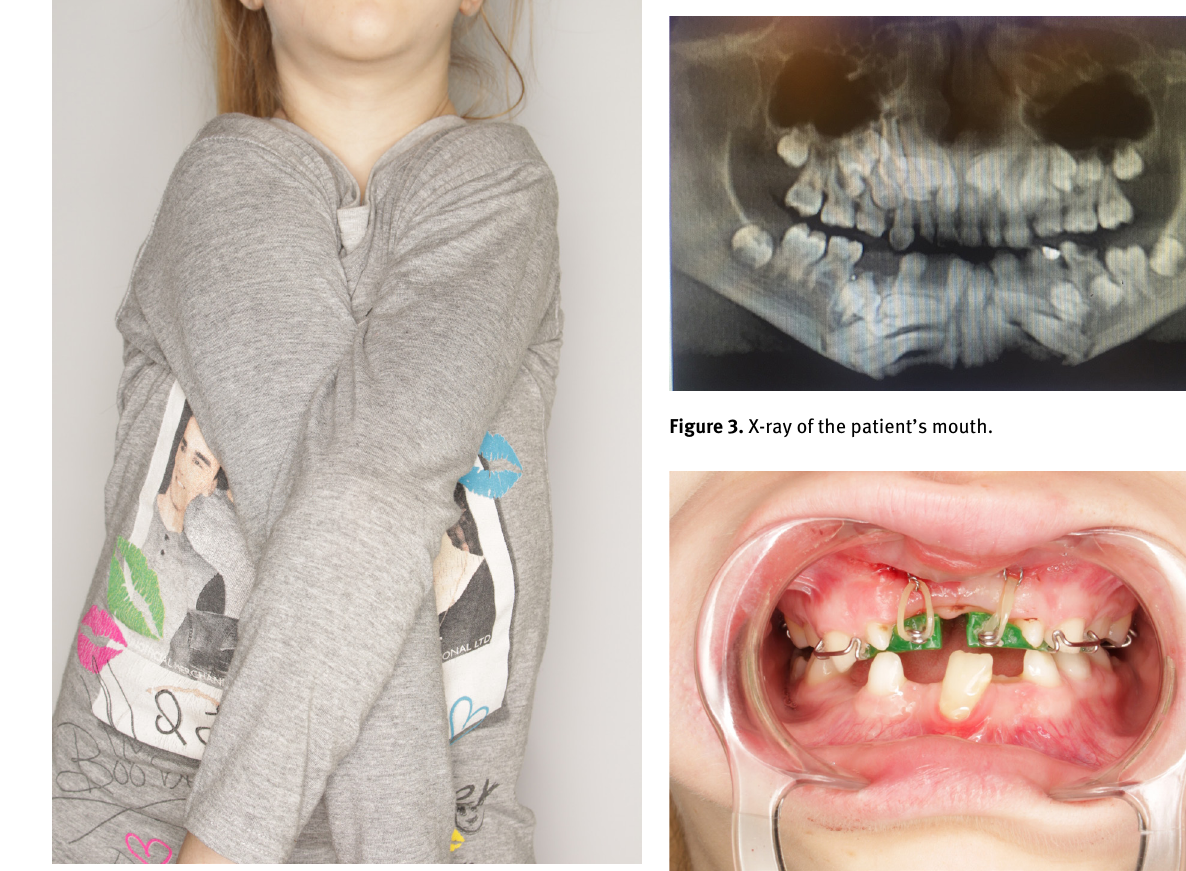
Figure 1. The patient`s arms hypermobility